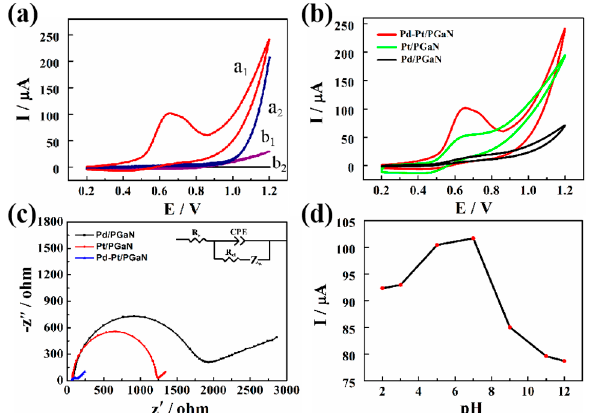
Figure 4. ( a ) CVs of Pd-Pt/PGaN electrode (a 1 and a 2 ) and PGaN electrode (b 1 and b 2 ) in 0.1 M PBS (pH 7) solution in the presence (a 1 and b 1 ) and absence (a 2 and b 2 ) containing 1 mM NaNO 2 . ( b ) CVs